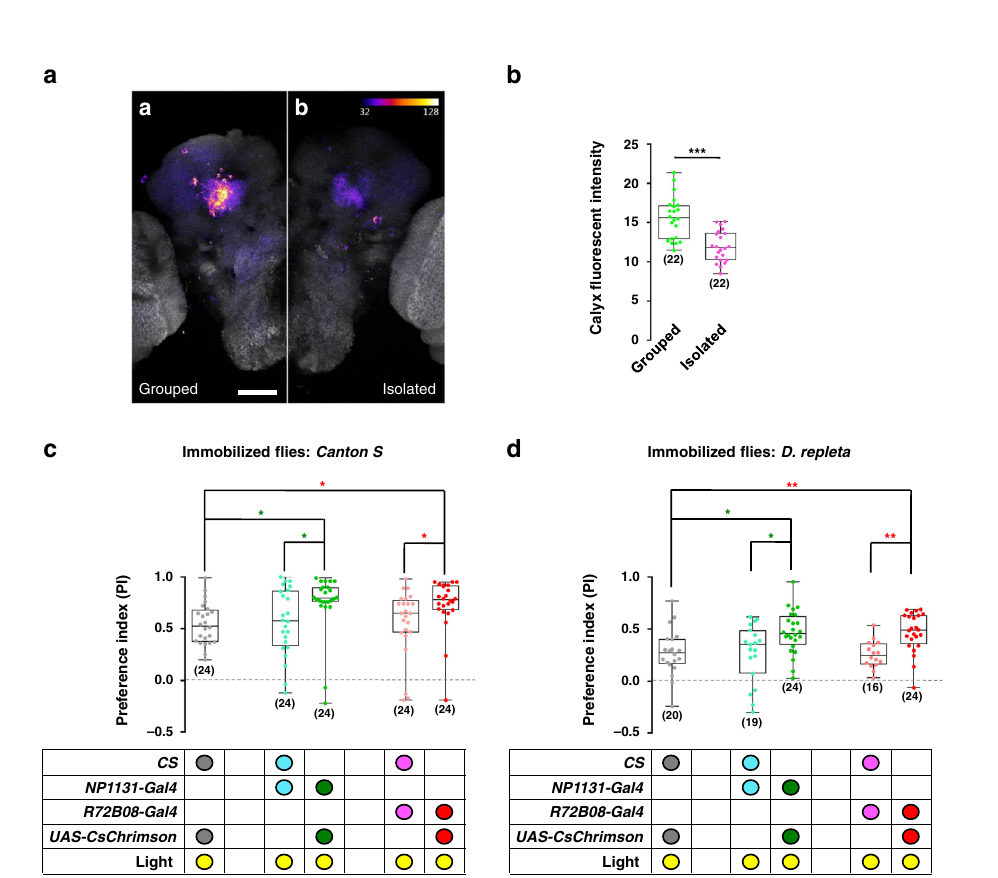
Fig. 4 Activation of KC γ neurons increases social motivation in Drosophila . a Social experience increased neural activity in KC γ neurons. Comparison of confocal images of the KC γ neurons in fl ies bearing R72B08-Gal4, UAS-mLexA-VP16-NFAT , LexAop-CD2-GFP , and LexAop-CD8-GFP-2A-CD8-GFP transgenes revealed that fl ies reared in a group (Grouped, a -a) exhibited more activity than fl ies reared individually (Isolated, a -b). Scale bars = 50 μ m. b Quanti fi cation of signal intensity in the calyx regions of grouped and isolated fl ies. c Optogenetic activation of NP1131-Gal4 or R72B04-Gal4 labelled KC neurons elevated levels of social attraction between the fl ies of the same species. Attractor fl ies were wild-type Canton S . d Activating the NP1131-Gal4 or R72B04-Gal4 labelled KC γ neurons also increased attraction between species. Attractor fl ies were wild D. repleta . The results are presented as a box and whisker plot; the whiskers indicate the minimum and maximum, the box includes the 25th – 75th percentile, and the line in the box indicates the median of the data set. Statistical analysis: one-way ANOVA followed by Dunnett ’ s test was used for comparison of all boxes vs. control box. * P < 0.05, ** P < 0.01, *** P <